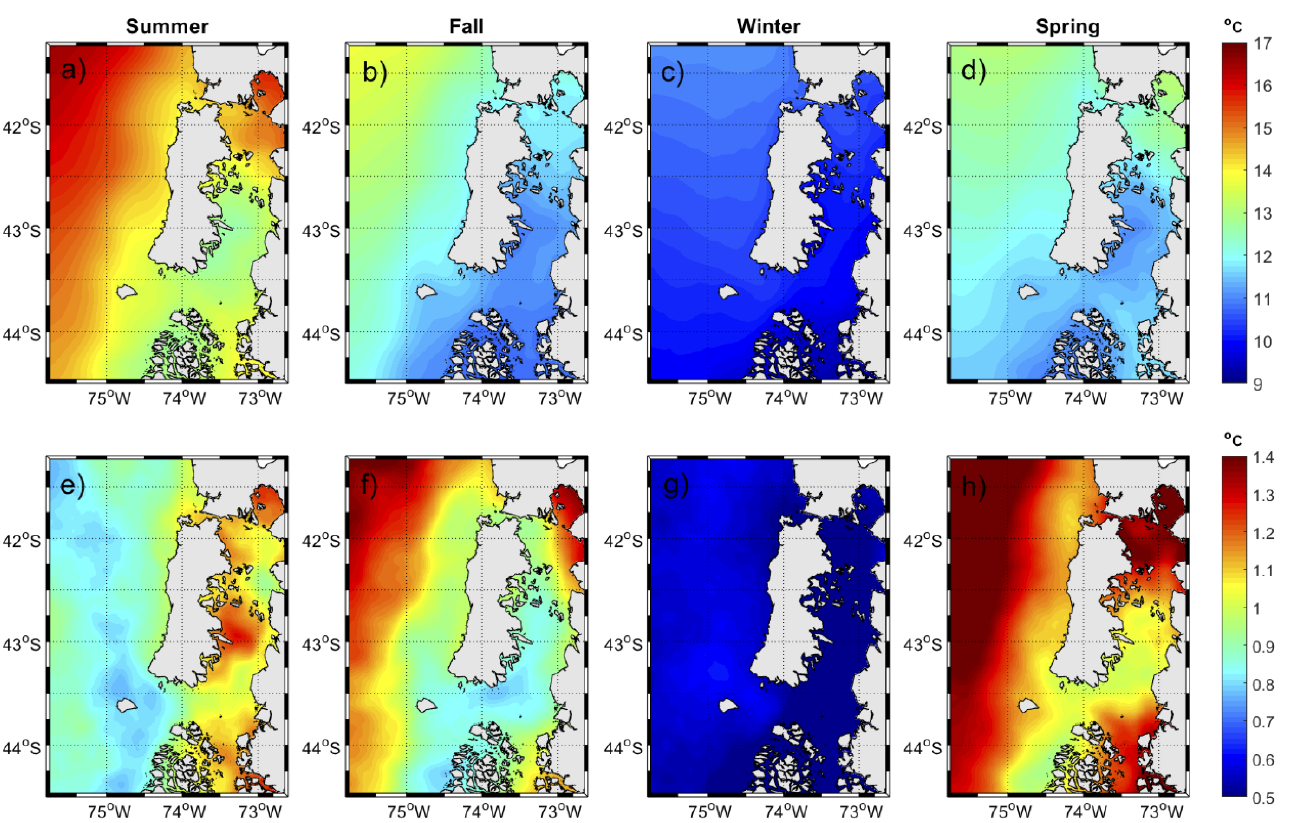
Figure 2. Seasonal climatology (2003–2019) of SST in the Inner Sea of Chiloé and its adjacent coastal ocean. (upper panels) averages and (lower panels) standard deviations for ( a , e ) summer (January, February, March), ( b , f ) fall (April, May, June), ( c , g ) winter (July, August, September), and ( d , h ) spring (October, November, December). For reference of locations see Figure